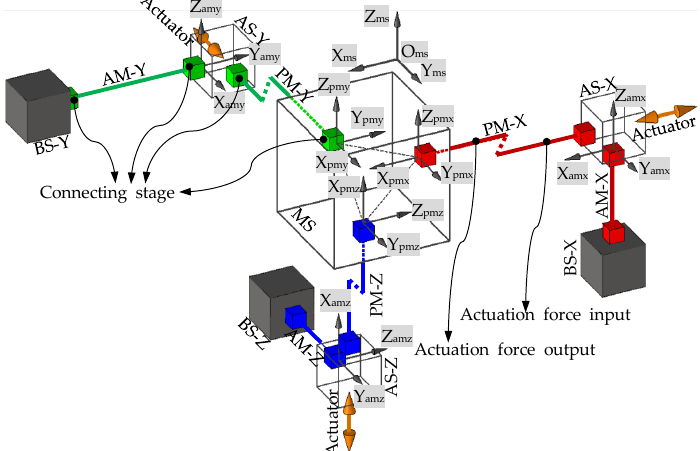
Figure 1. Schematic diagram of a decoupled three-legged XYZ CPM system and the coordinate